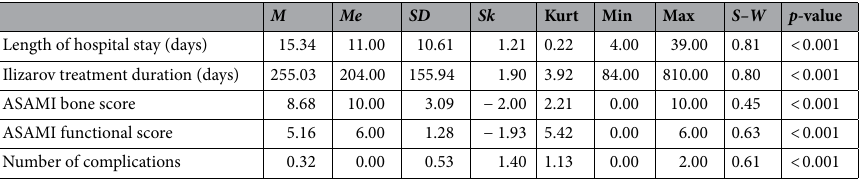
Table 4. Descriptive statistics and Shapiro–Wilk test results for quantitative variables in the patients who underwent Ilizarov treatment with no compression, n = 38). M mean, Me median, SD standard deviation, Sk. skewness, Kurt. kurtosis, Min minimum, Max maximum, S–W Shapiro–Wilk test result, p-value significance of normality of distribution.